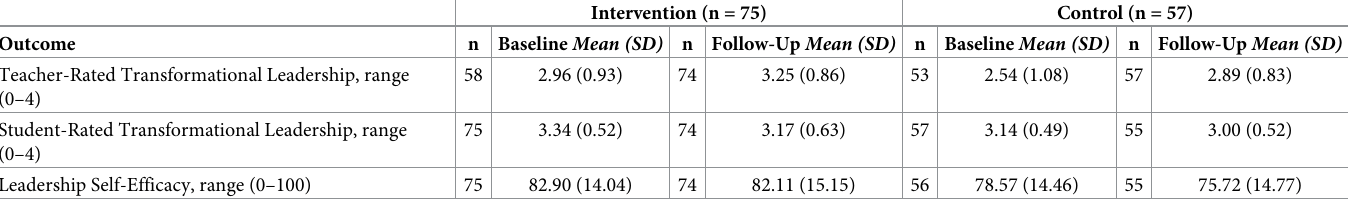
Table 1. Teacher and Grade 6/7 student outcomes at baseline and